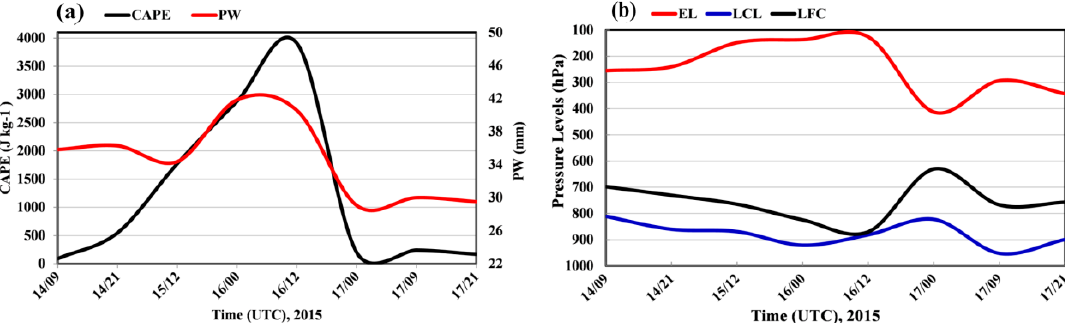
Figure 5. ( a ) CAPE and PW, while ( b ) EL, LCL, and LFC over Jeddah during the period from 09:00 UTC 14 November to 21:00 UTC 17 November 2015. (CAPE: convective available potential energy, PW: precipitable water, EL: Equilibrium Level, LFC: Level of Free Convection, LCL: Lifting Condensation Level).